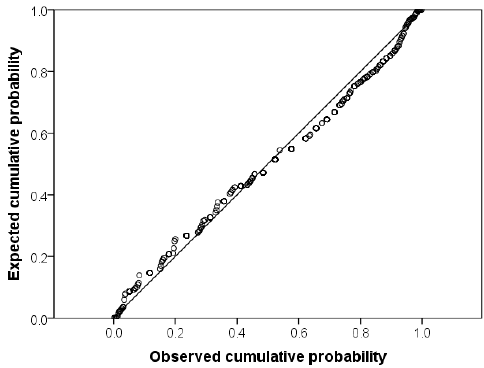
Figure 5. P-P graph of logarithm of the detected daily average concentrations of As.